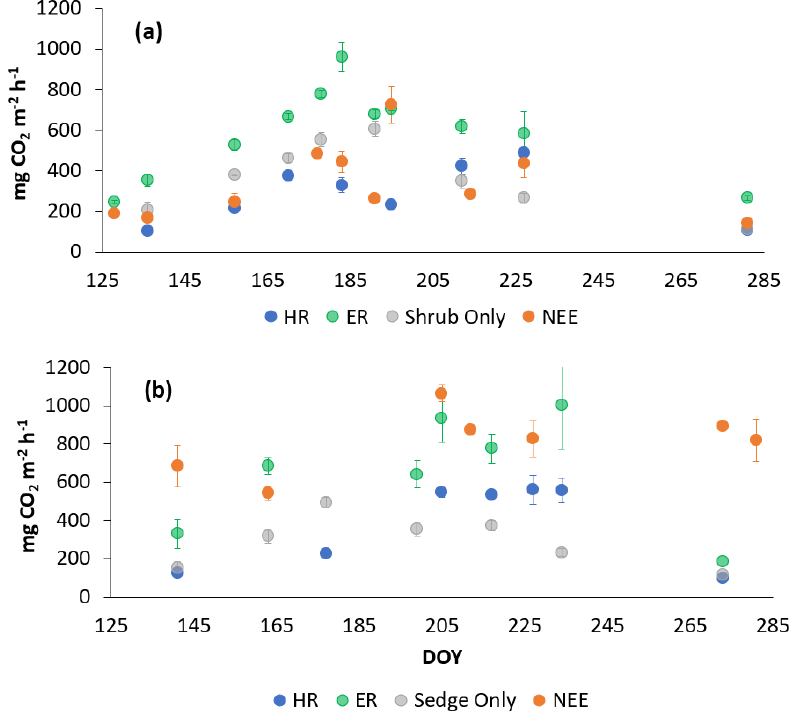
Figure 4. Average CO 2 fluxes in the (a) shrub plots and (b) sedge plots across the growing season of 2019 ( ± standard error).